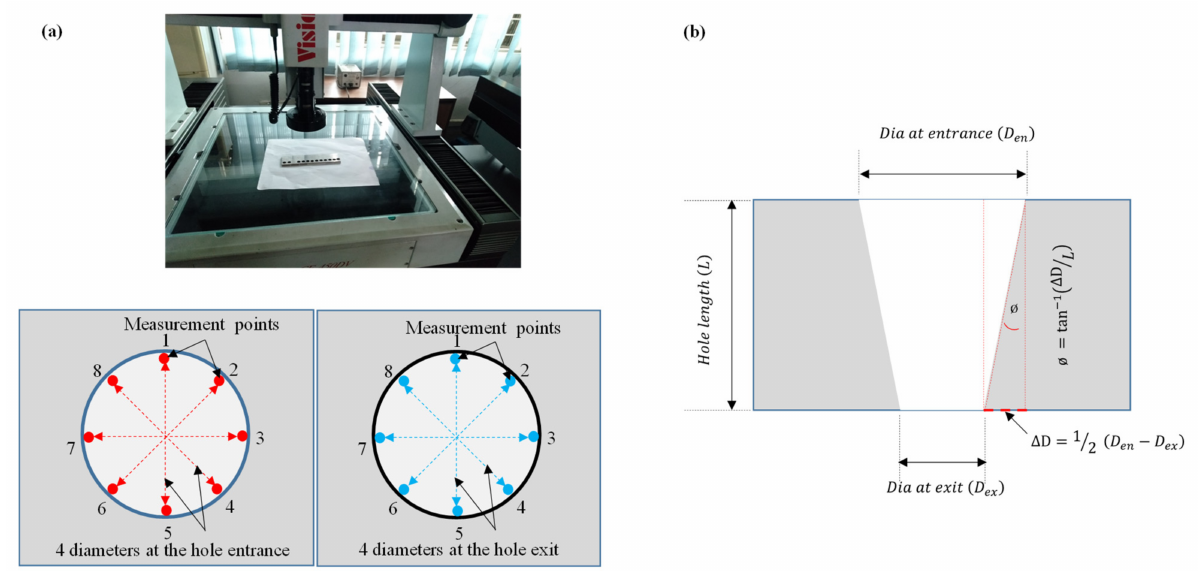
Figure 3a. The change in diameters (entry and exit) and length of hole was used to obtain the taper angle. The formula to calculate the taper angle is labelled along with the other required terms as illustrated in Figure 3b.